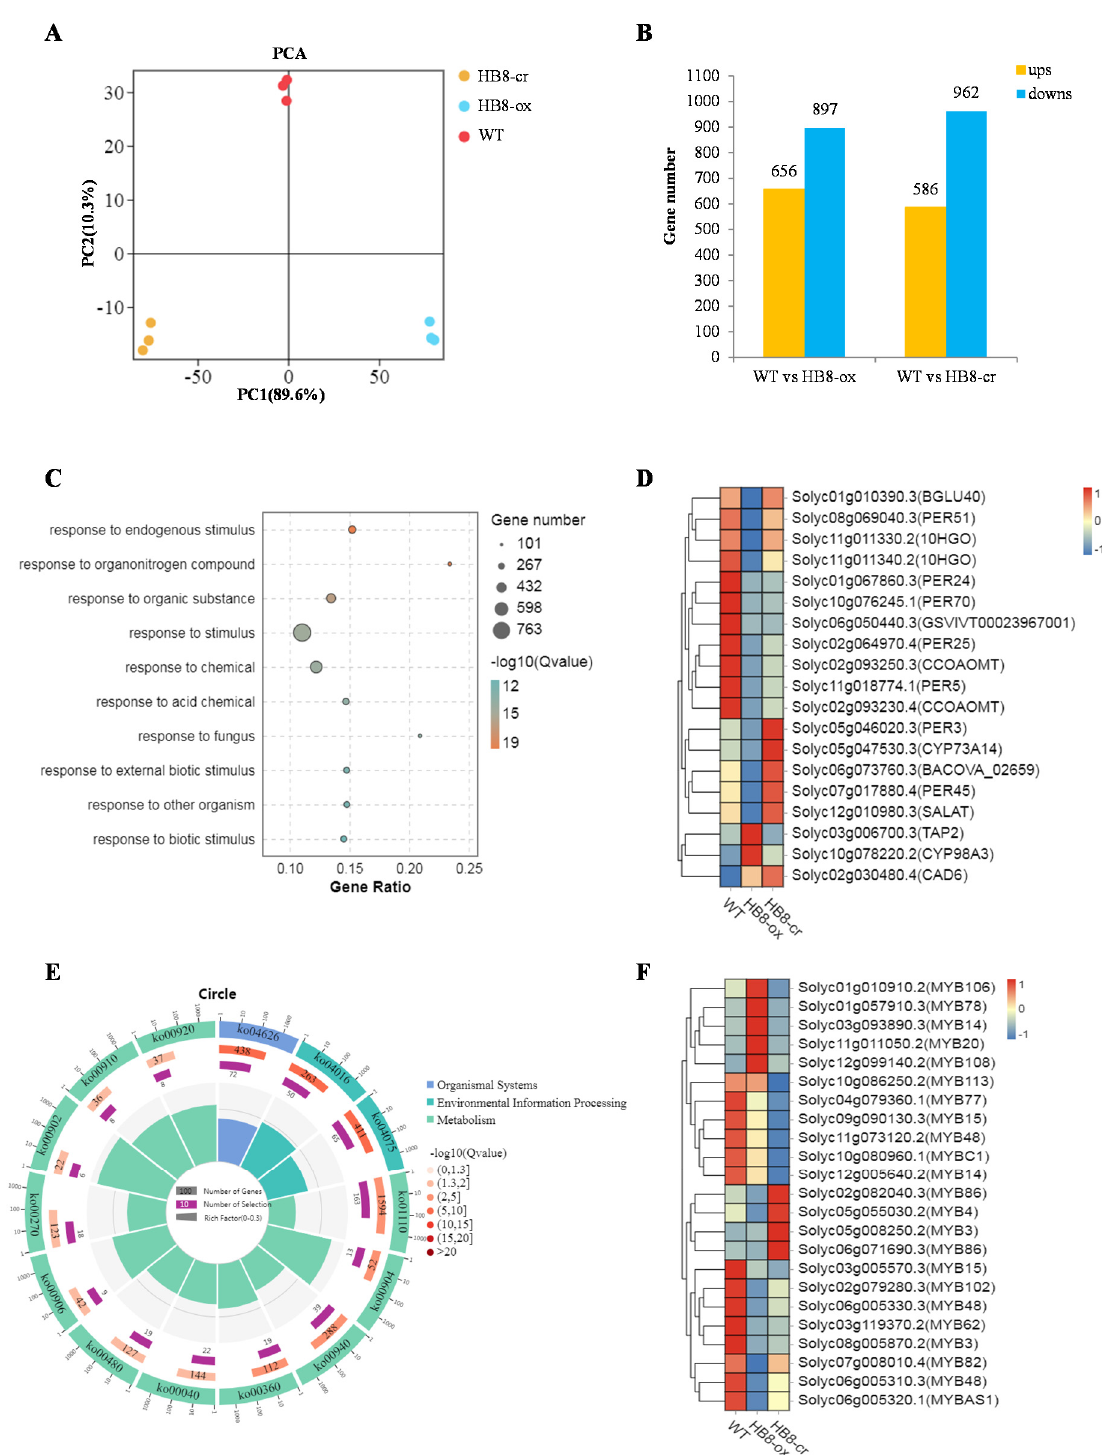
Figure 4. Differentially expressed genes (DEGs) analysis in WT, SlHB8-ox, and SlHB8-cr plants. ( A ) Principal component analysis (PCA) of the three group samples (WT, red; SlHB8-cr, yellow; SlHB8-ox, blue); the x-axis represents the first principal component and the y-axis represents the second. ( B ) Histograms showing the DEGs number in WT vs. SlHB8-ox and WT vs. SlHB8-cr. ( C ) Top ten significantly enriched GO terms. ( D ) Heatmap of DEGs involved in the phenylpropanoid biosynthesis pathway. ( E ) Heatmap of DEGs belong to the MYB transcription factor. ( F ) Significantly enriched KEGG terms.